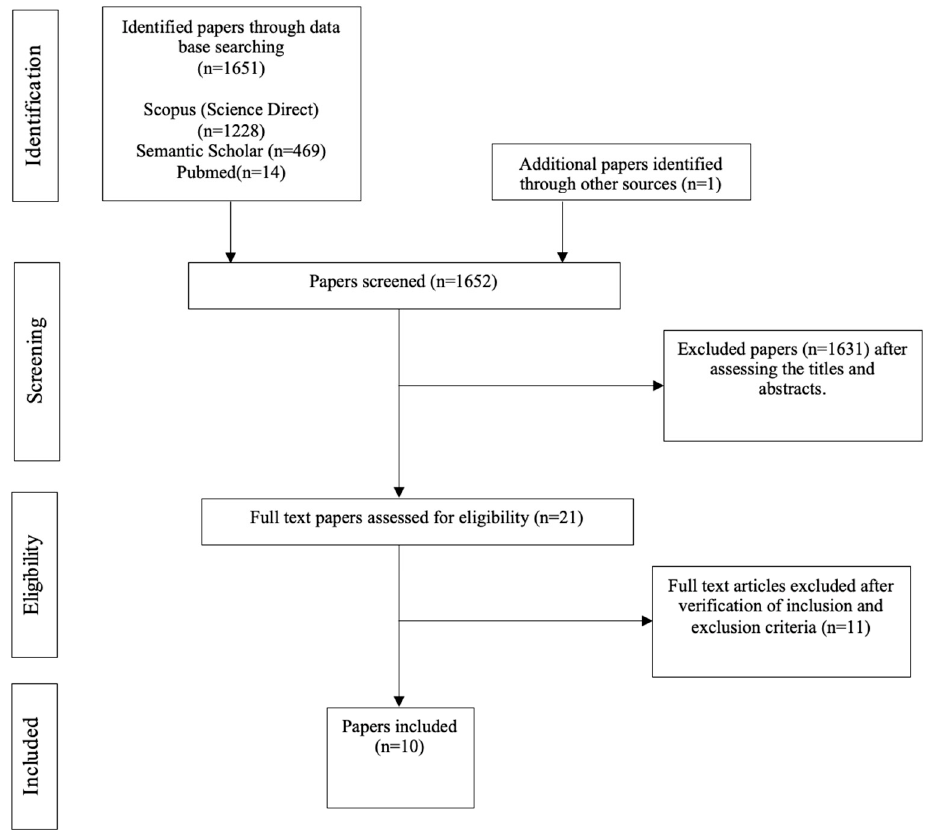
Figure 1. PRISMA flowchart of paper selection research.